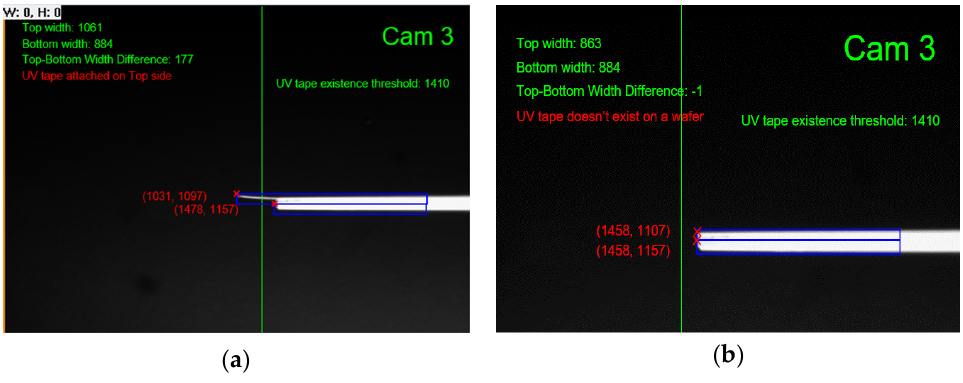
Figure 10. Detection of UV tape attached: ( a ) with UV tape attached; ( b ) without UV tape.